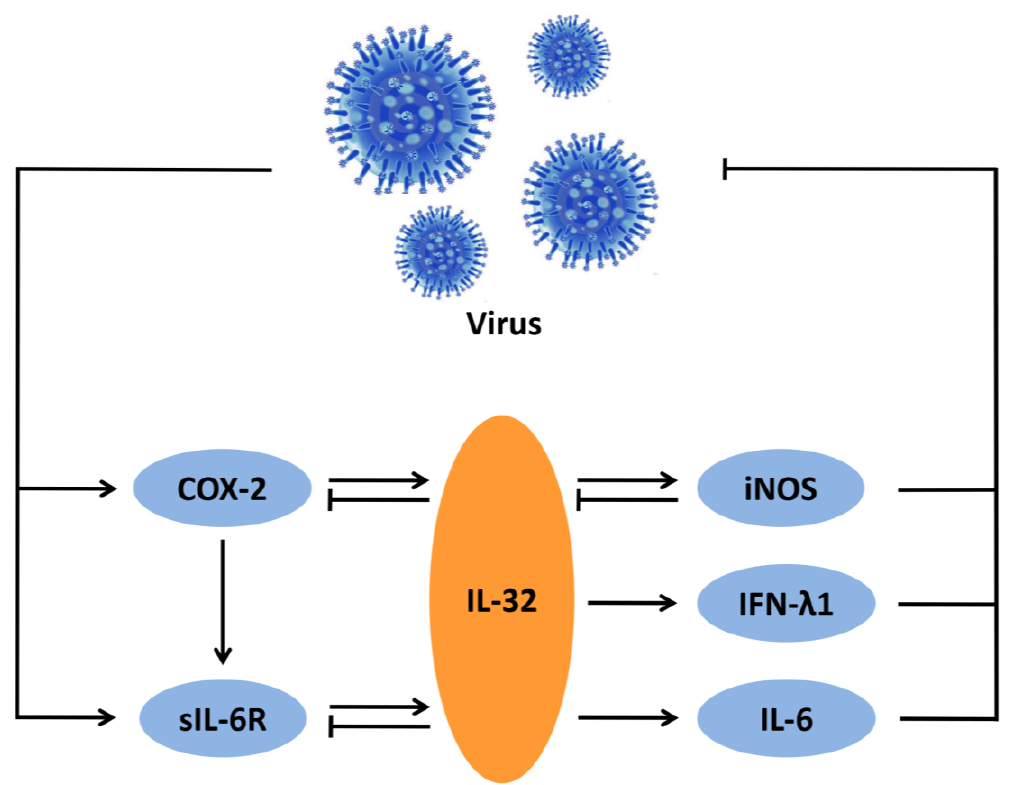
Figure 1. The IL-32-mediated inflammatory network against viral infection. Virus infection induces COX-2 and sIL-6R expression, which upregulates IL-32 production, resulting in increases of iNOS, IFN- λ 1, and IL-6 levels. However, elevated IL-32 level feedback inhibits COX-2 and sIL-6R expression; iNOS also has a negative feedback effect on IL-32. This network plays a key role in host response to viral infection.